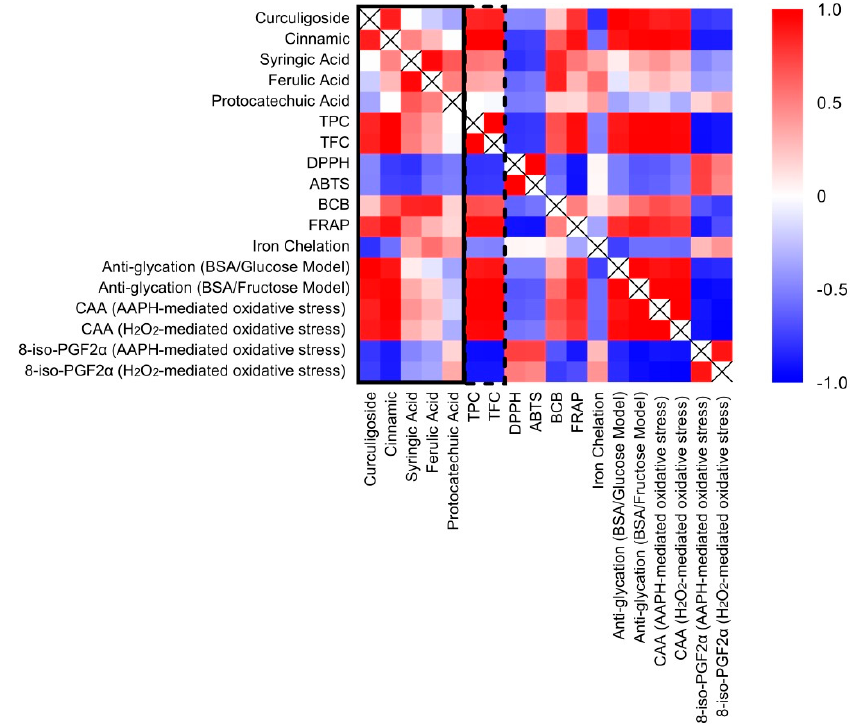
Figure 6. Correlation heat map of identified phenolic compounds and antioxidant activities. Each cell indicates the Pearson’s correlation coefficient value, r , for a pair of phenolic compound/s or antioxidant activities. Positive correlations (0 < r < 1.0) are displayed in red color, and negative correlations ( − 1.0 < r < 0) are displayed in blue color. Color intensity is proportional to the correlation coefficients.